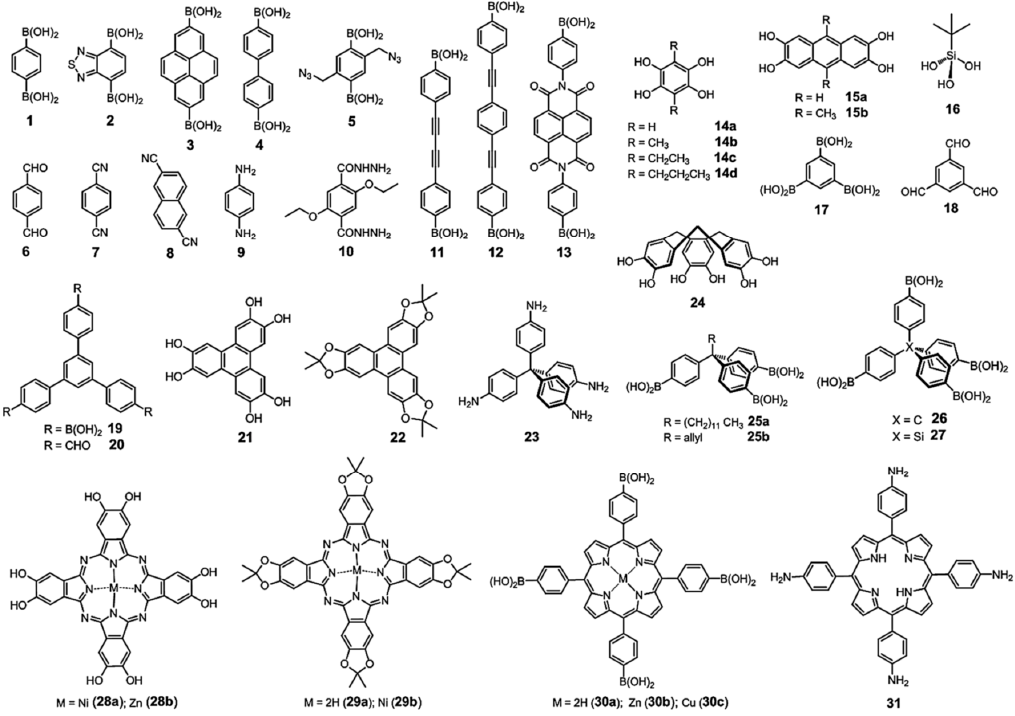
Figure 1. Some of the building units that have already been successfully used for the syntheses of covalent organic frameworks (COFs). Reprinted from Ding et al. [3] with permission of the Royal Society of Chemistry (RSC).